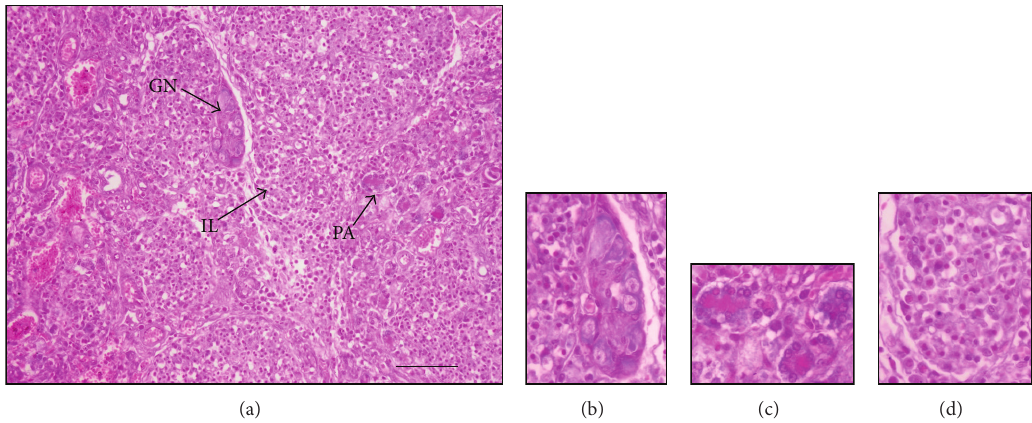
Figure 4: Developing pancreatic tissue in the bigger mass. (a) Low magnification microphotograph showing islets of Langerhans (IL) in the endocrine pancreatic tissue and pancreatic acini (PA) in the exocrine portion. A group of ganglionic neurons (GN) can also be observed. (b, c, and d) correspond to higher magnifications of the regions described in (a). H/E staining; bars (a) = 223 𝜇 m; (b) = 179 𝜇 m; (c) = 179 𝜇 m: (d) = 179 𝜇